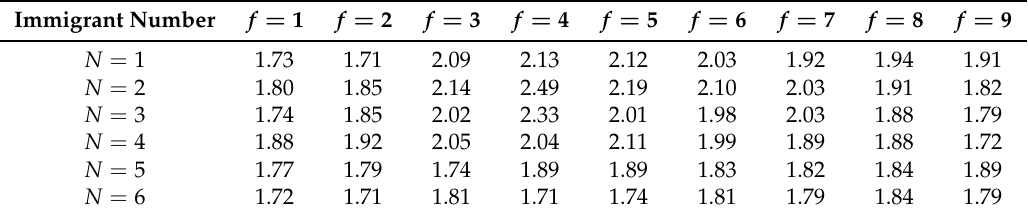
Table 1. The fitness values of the optimal solutions obtained by using different immigrant strategies. Immigrant Number f =